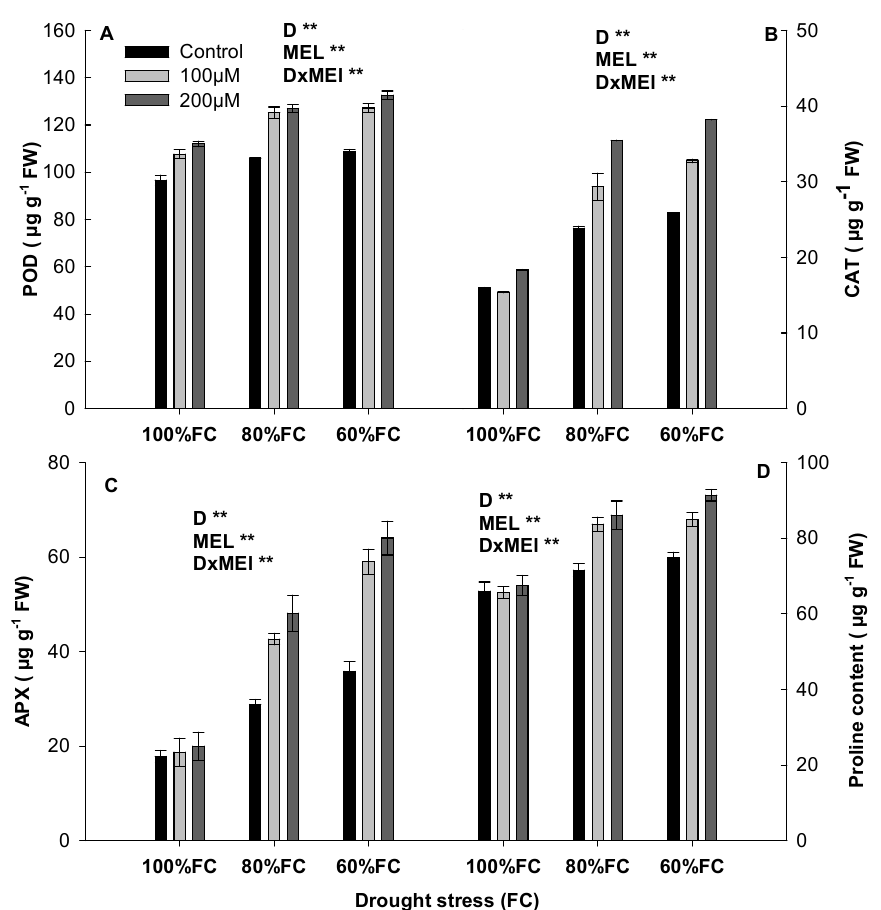
Figure 2. Changes in anti-oxidant activity ( A ) POD (µgg −1 ); ( B ) CAT(µgg −1 ); ( C ) APX (µgg −1 ); and ( D ) Proline content (µgg −1 ) as affected by rooting application of Melatonin under drought stress. 100% FC represents no stress, 80% FC represents mild stress, and 60% FC represents severe stress. Error bars represents standard error of replicates. ** represent significant difference at 1% level of probability. D represent drought stress levels, while MEL represents MEL Levels, and DxMEL is the interaction between both factors.